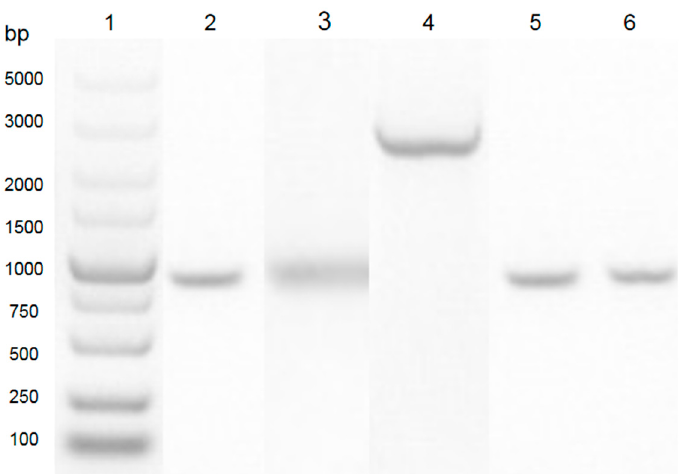
Figure 1. PCR amplification of the aiiA DH82 gene from B. velezensis (DH82 strain). Lane 1: DNA ladder (Takara, 3428Q). Lane 2: PCR product from B. velezensis (DH82 strain; aiiA homologue gene). Lane 3: DNA fragment of B. velezensis (DH82 strain; aiiA homologue gene) digested with enzymed Nde I and Xho I. Lane 4: cloing vector of pET28a digested with enzymes Nde I and Xho I. Lane 5: positive band confirmed from E. coli DH5 α . Lane 6: positive band confirmed from E. coli BL21.